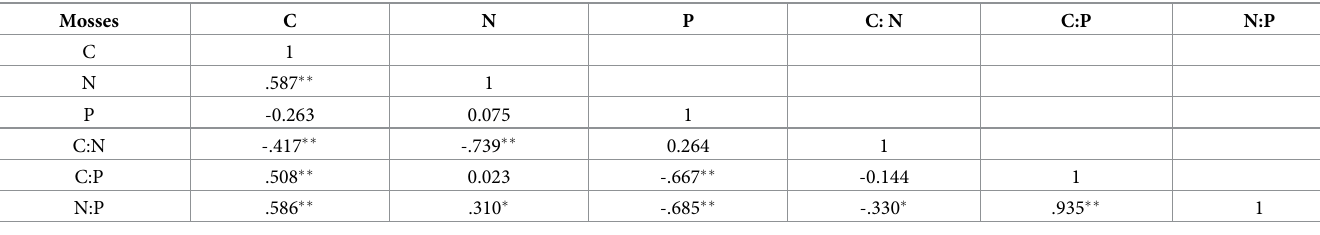
Table 5. Pearson correlation analysis of the C, N, and P contents and stoichiometric ratios of mosses. Mosses C